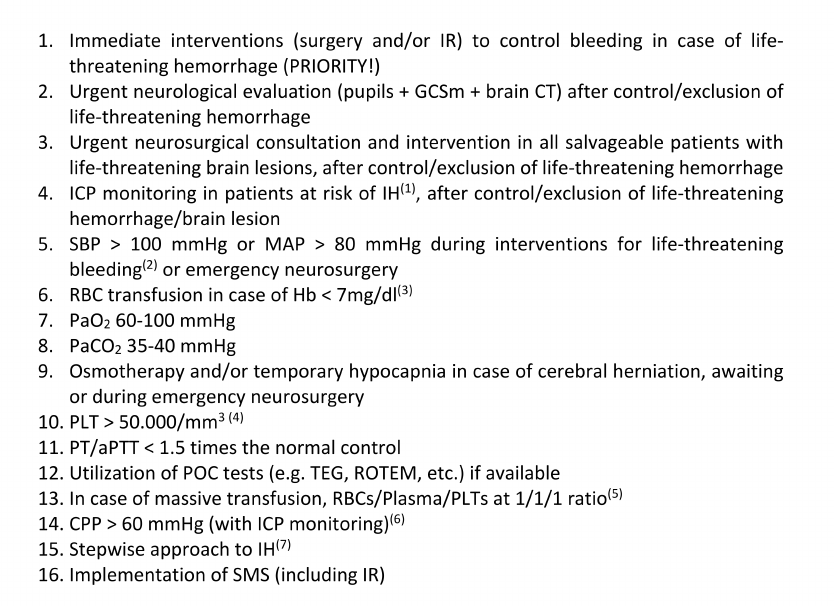
Figure 2. Summary of the World Society of Emergency Surgery consensus conference recommenda- tions, regarding the monitoring and management of severe adult traumatic brain injury patients with polytrauma in the first 24 h (modified from Picetti et al. [32]). (1) Coma plus radiological signs of IH. (2) Temporarily lower values in case of difficult bleeding control. (3) Higher threshold in patients at “risk” (e.g., elderly, pre-existing heart disease, etc.). (4) Higher values for emergency neurosurgery (including ICP probe insertion). (5) Later on, the ratio may be modified according to laboratory values. (6) This value can be personalized considering neuromonitoring data and cerebral autoregulation status. (7) If impossible to target the underling pathophysiology of IH.